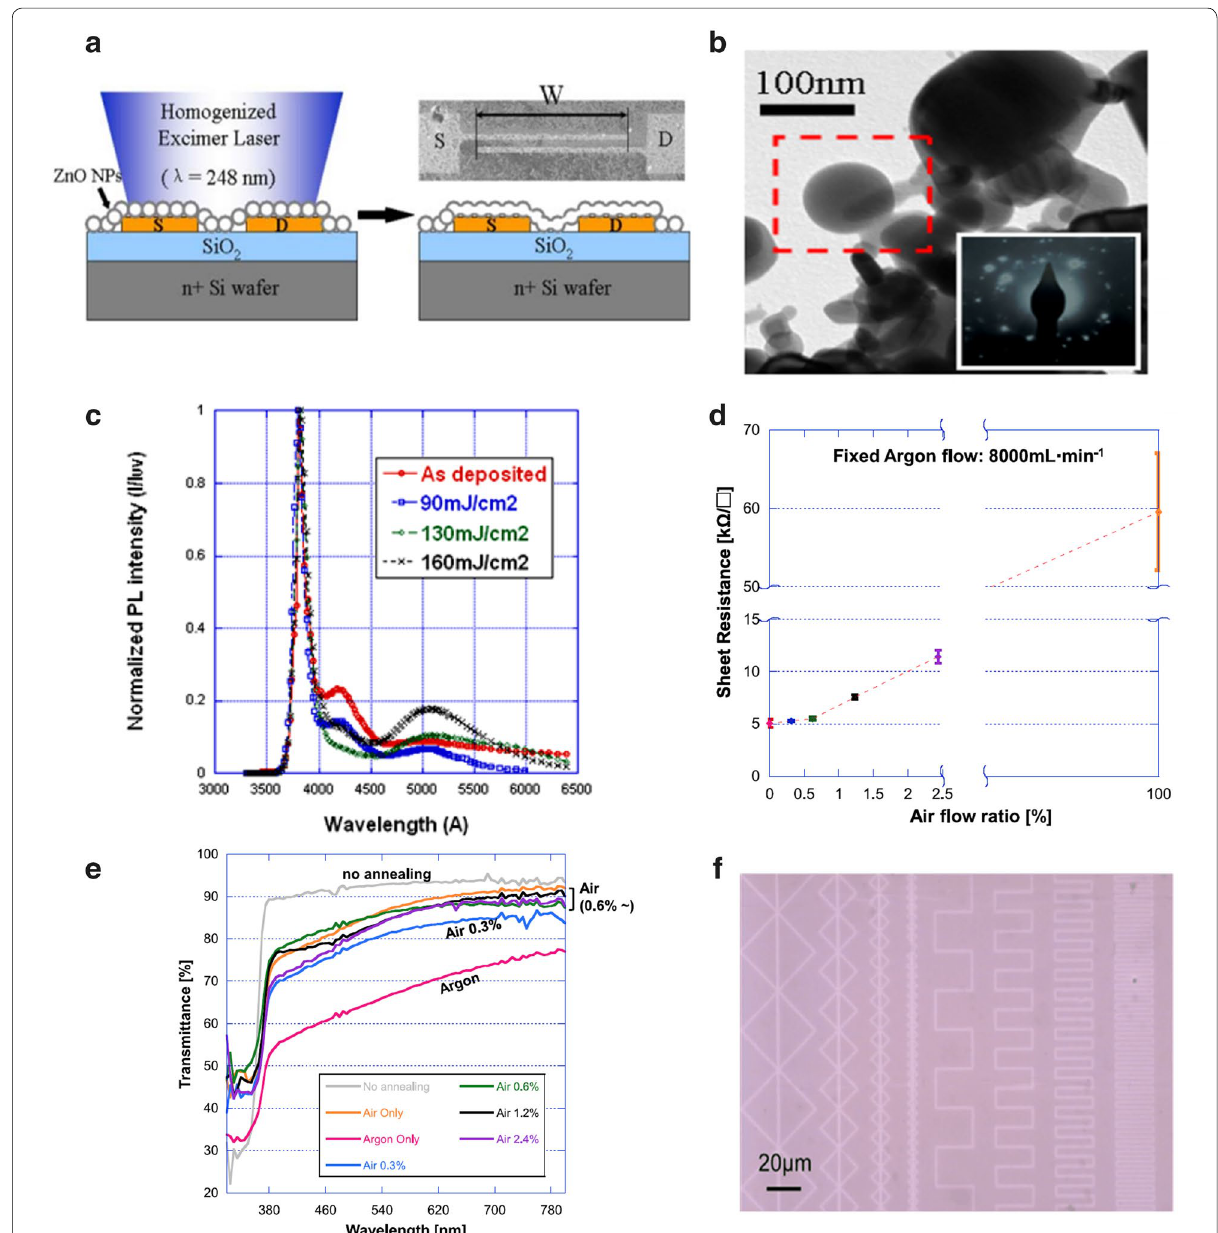
Fig. 3 a Schematic side view of the excimer laser annealing process and the ZnO NP field-effect transistor structure. S and D indicate the source and drain electrodes, respectively. The top right inset presents a top-view SEM image of transistor electrodes with a layer of deposited ZnO NPs. b Transmission electron microscopy (TEM) image of the ZnO NP film after excimer laser irradiation. The inset shows the diffraction pattern for the marked region. c Room-temperature photoluminescence spectra of the ZnO thin film with and without laser annealing ( a – c reproduced with permission from Ref. [42]. Copyright Springer, 2009). d Sheet resistance of the ZnO thin film depending on the background gas during laser annealing. e Transmittance of ZnO thin films annealed in background gases with different compositions. f Optical microscope image of 1.5-µm-line width patterns generated on the ZnO thin film ( d – f reproduced with permission from Ref. [44]. Copyright Springer,